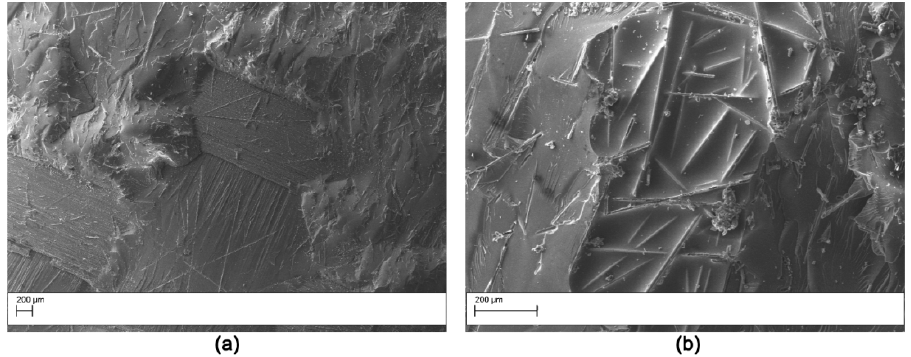
Figure 12. SEM of the fracture surface for the AP1 modified DCB sample (Magnification 5000×). The analysis was carried out on the two halves resulting by specimen opening. ( a ) right side, ( b ) left side.